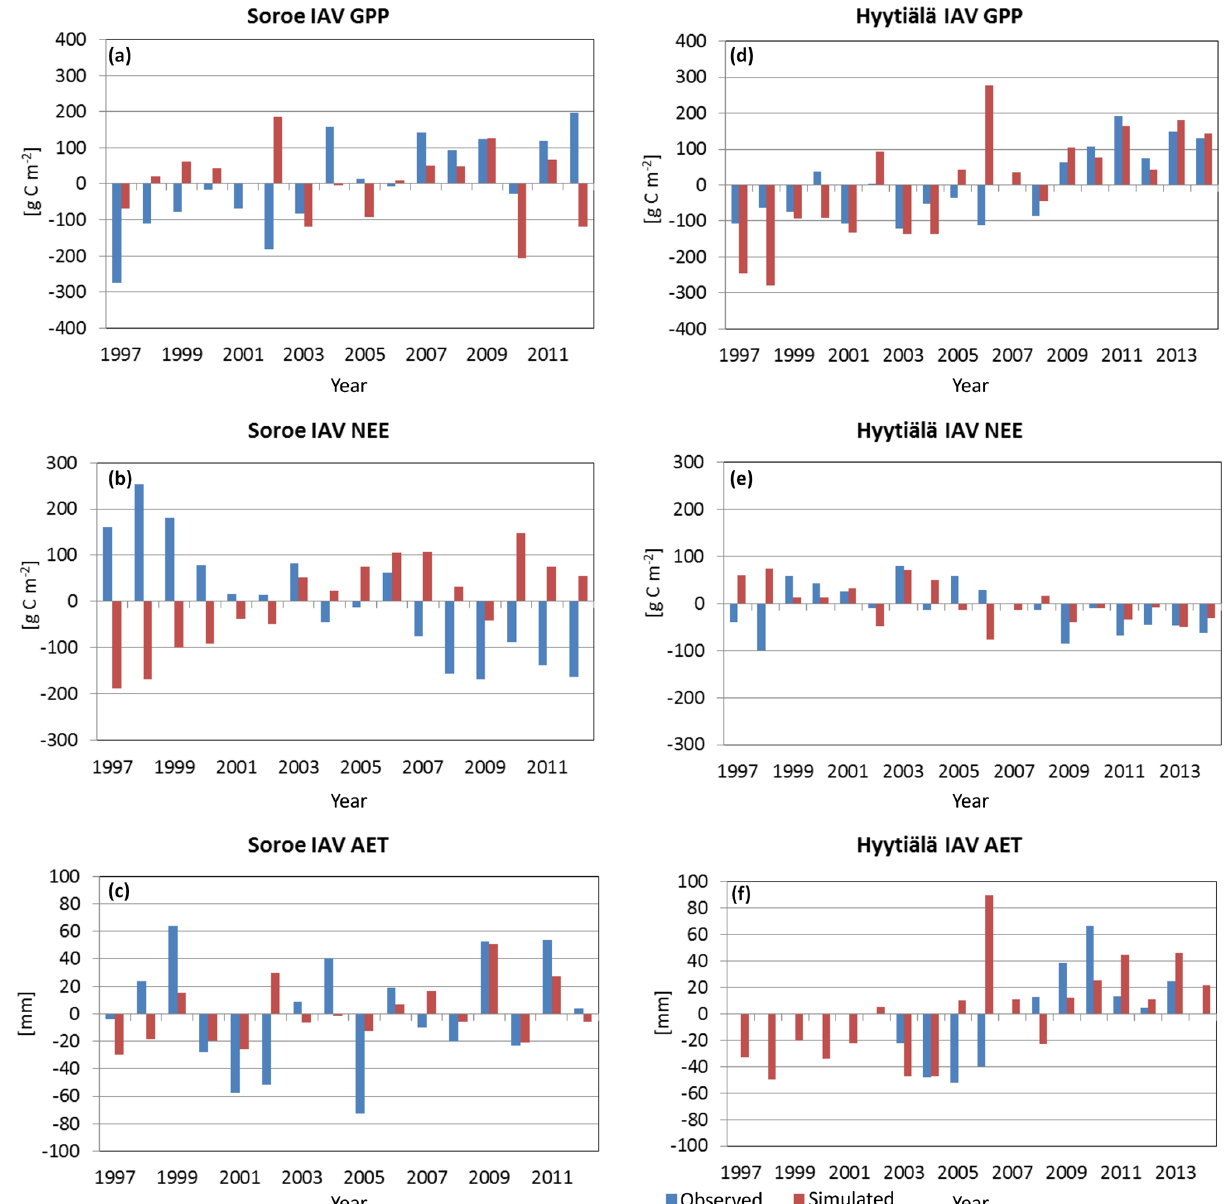
Figure 7. Inter-annual variability (IAV) of GPP, NEE, and AET (sim – simulated and obs – observed) in Sorø (a–c) and Hyytiälä (d–f)